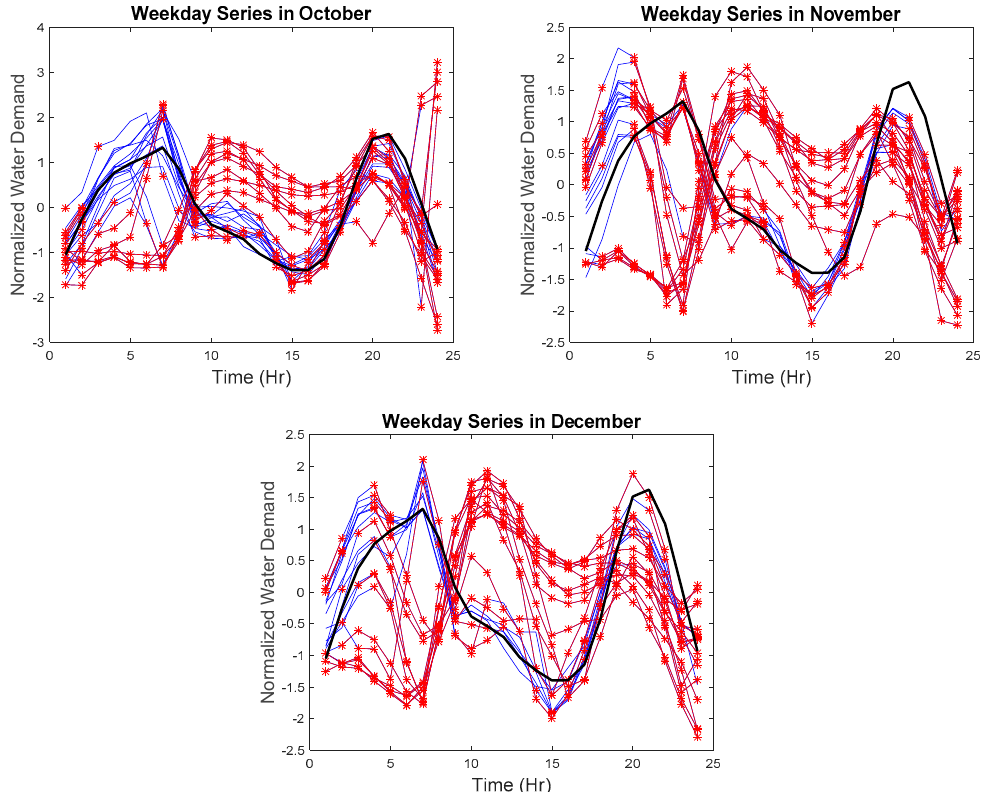
Figure 11. Normalized weekday series with detected anomalies (October–December). Table 3. Parameters of missed detected anomalies.